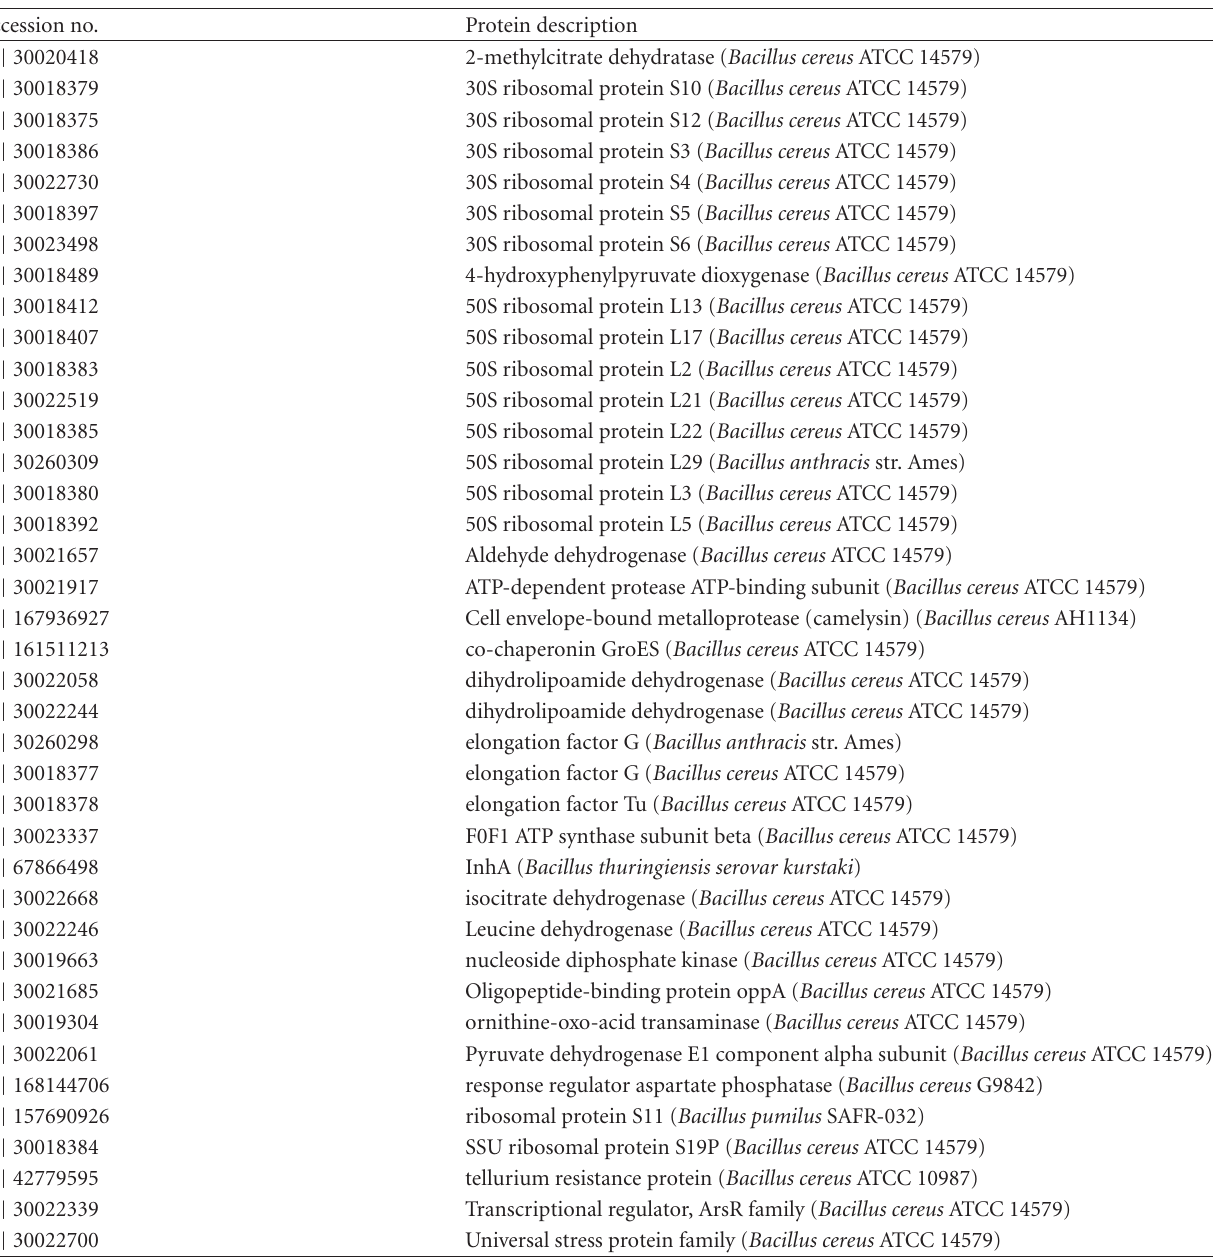
Table 1: The same proteins identified in the three